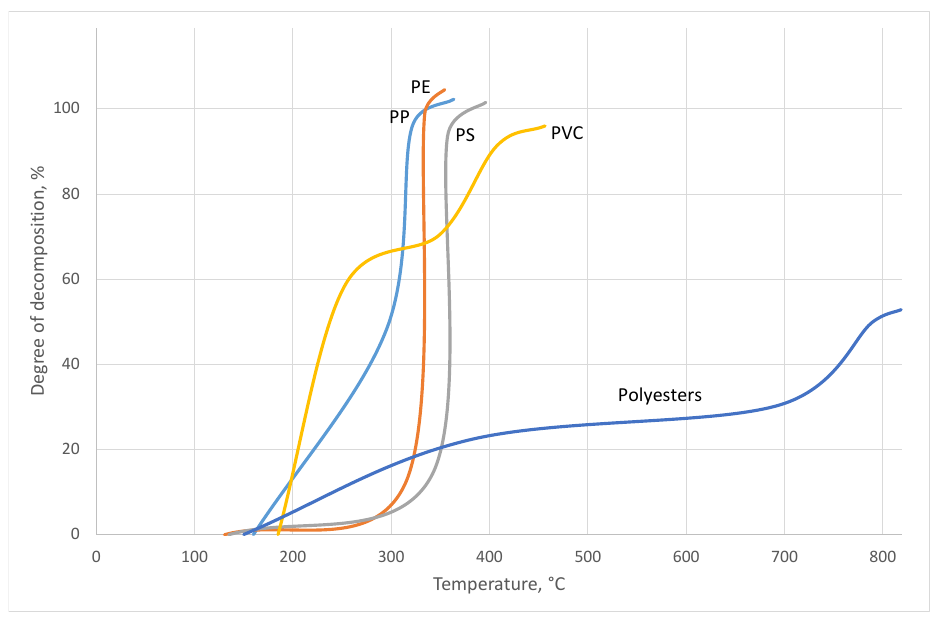
Figure 12. Thermogravimetric (TGA) analysis of studied polymers (own study based on [20]).